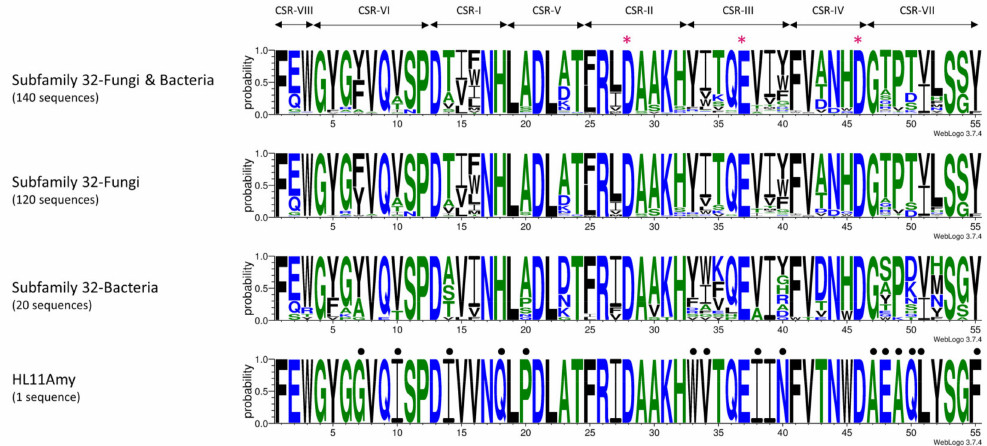
Figure 3. Sequence logos of eight conserved sequence regions (CSRs) found in HL11Amy and α - amylases from studied GH13_32 subfamily. The catalytic triad including aspartic acid in CSR-II, glutamic acid in CSR-III and aspartic acid in CSR-IV are indicated by asterisks. The unique amino acid residues only found in HL11Amy are indicated by black circles.